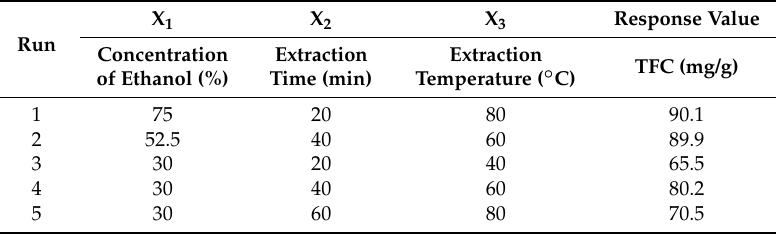
Table 1. Factors and levels in the response surface central composite design arrangement and experimental